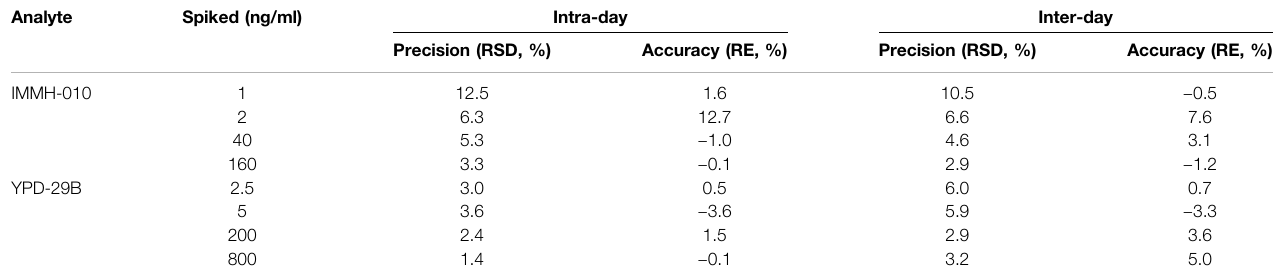
TABLE 2 | Intra-day ( n (cid:1) 6) and inter-day ( n (cid:1) 18) precision and accuracy of IMMH-010 and YPD-29B in rat plasma. Analyte Spiked (ng/ml)